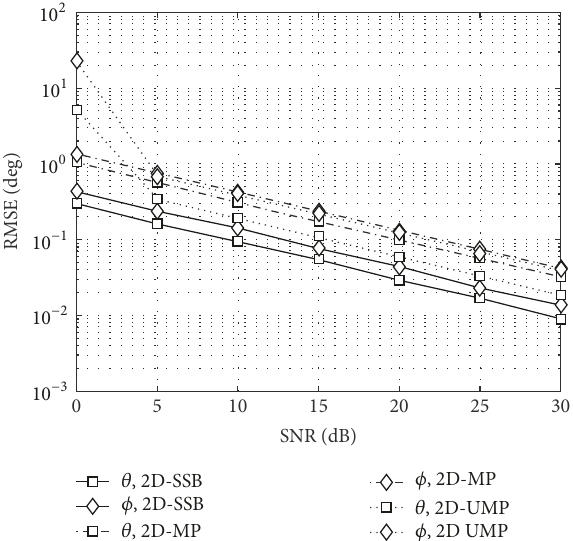
Figure 2: RMSEs of azimuth and elevation angles against with SNR for the dispersed sources, where (𝜃 1 , 𝜙 1 ) = (25 ∘ , 55 ∘ ) and (𝜃 2 , 𝜙 2 ) = (45 ∘ , 65 ∘ )